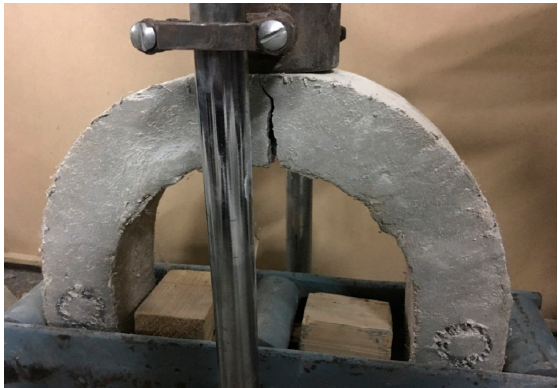
Figure 17. Final failure crack in U-shape specimen under the drop weight test.